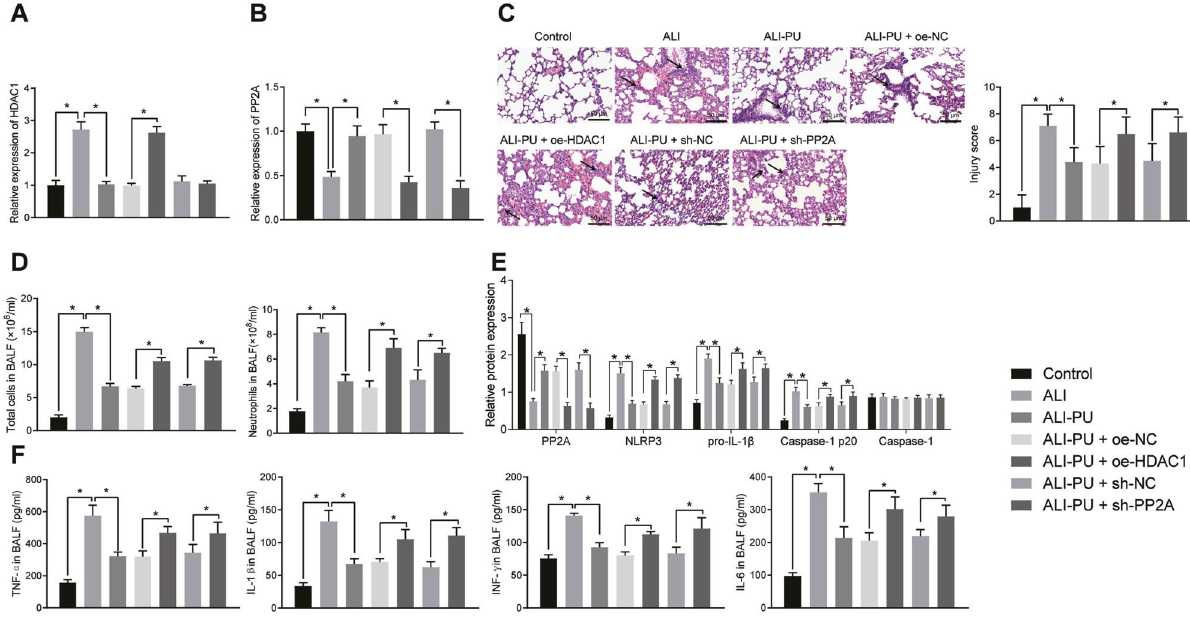
Fig. 5 Overexpressed HDAC1 or silencing PP2A suppresses the protective effect of PU on ALI in mice. A The expression of HDAC1 in lung tissues of ALI mice after PU, oe-HDAC1 or sh-PP2A treatment, assayed by RT-qPCR. B The expression of PP2A in lung tissues of ALI mice after PU, oe-HDAC1 or sh-PP2A treatment, assayed by RT-qPCR. C The pathological changes in animal models and lung tissues after transfection (× 200), assessed by HE staining. D The total number of cells and the number of neutrophils in BALF in animal models after transfection. E The expression of PP2A and NLRP3 in fl ammasome-related indicators in lung tissues of animal models after transfection, assayed by Western blot analysis. F The levels of in fl ammatory factors (TNF- α , IL-1 β , INF- γ and IL-6) in BALF of animal models after transfection, assayed by ELISA. * p < 0.05. n =